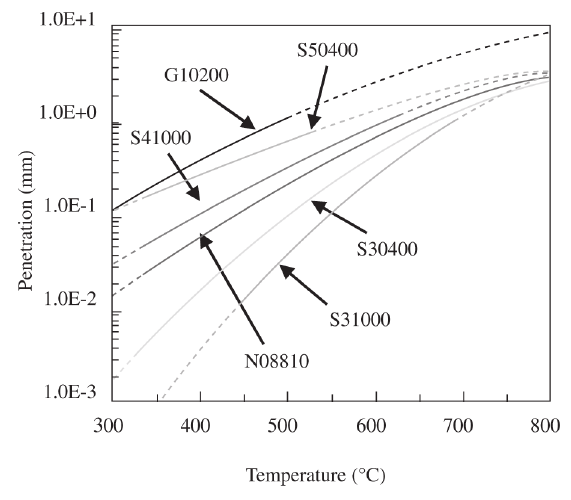
Figure 5. Effect of Temperature Upon Sulfidation Corrosion of Some Alloy Commonly Used in Sulfidizing Conditions After One Year 0.05 atma H2S and 0.5 atma H